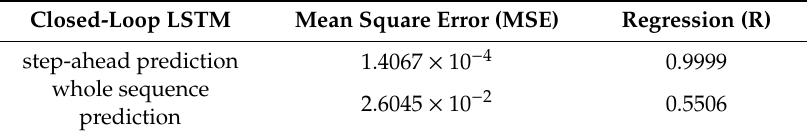
Table 6. Training results for the closed-loop